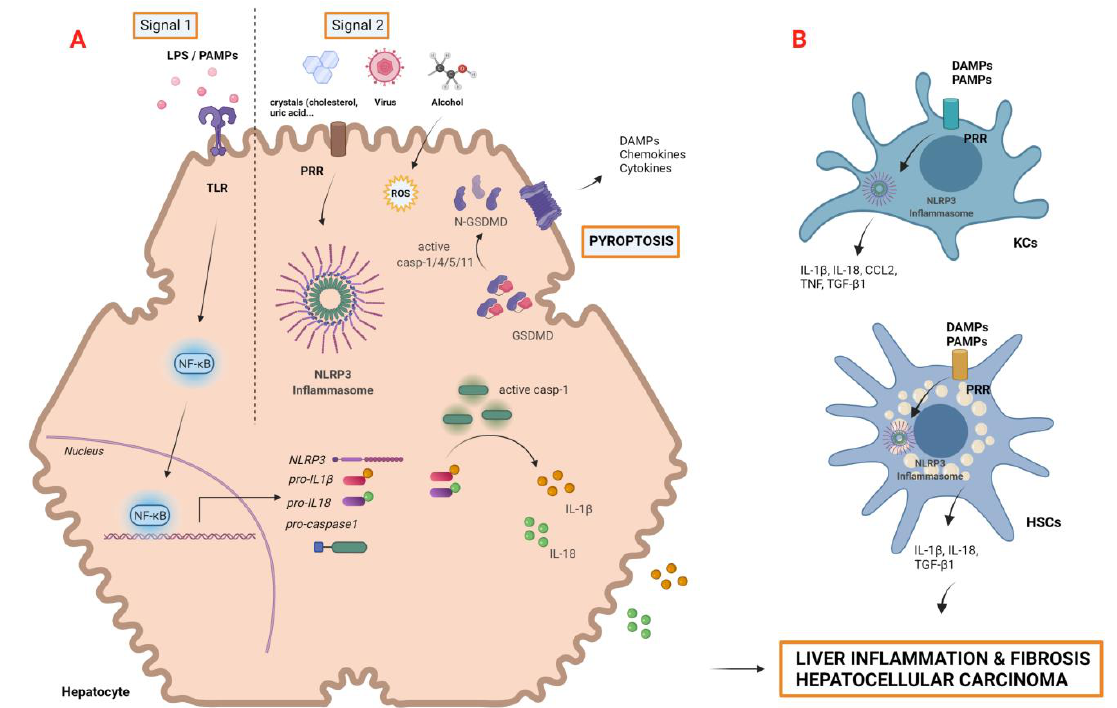
Figure 2. Activation of the NLRP3 inflammasome and canonical pyroptosis in liver cells. Various stimuli of liver damage might cause hepatocyte cell death and gut dysbiosis, leading to high exposure to DAMPs and PAMPs that activate liver inflammasomes: ( A ) In hepatocytes, NLRP3 inflammasome activation requires two steps: the priming signal (SIGNAL 1) is initiated by PAMPs such as LPS, which bind to their corresponding TLR and upregulate the expression of pro-IL- 1β, pro-IL-18, pro-caspase-1, and NLRP3 genes via NF- ƙ B signaling activation. The second signal (SIGNAL 2) is triggered by PAMPs and/or DAMPs and activates NLRP3, which, in turn, activates pro-caspase-1. Activated casp-1 cleaves IL- 1β and